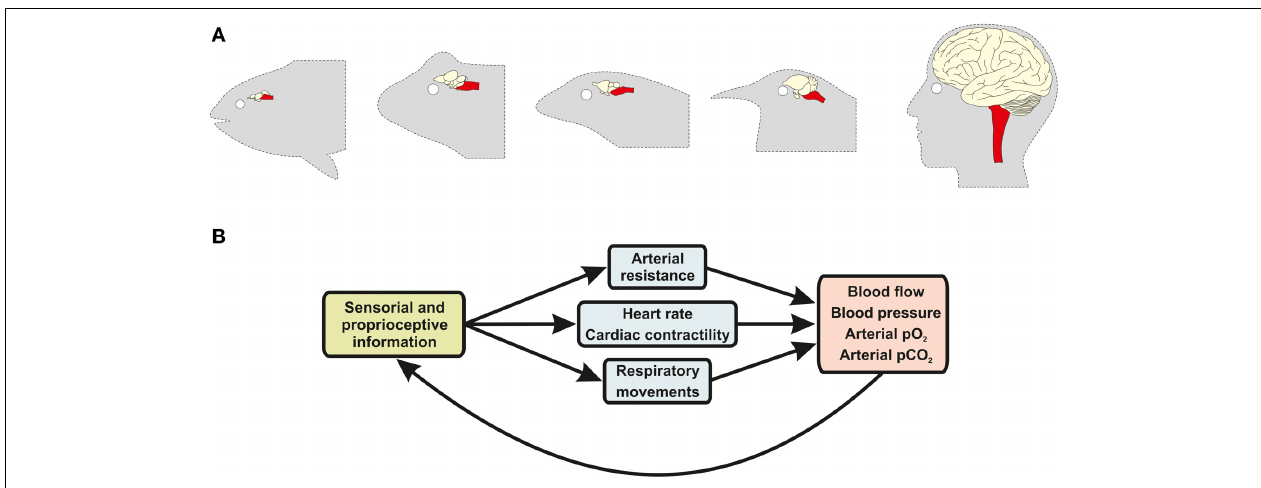
FIGURE 2 | Sensory-effector loops between the brain and the cardiovascular and respiratory systems regulate gas exchanges and blood flow. (A) Schematic illustrations of the brain of animals from five major vertebrate taxa, including bony fish, amphibians, reptiles, birds, and mammals (ordered from left to right). Brainstem anatomy and structure (red highlight) has remained conserved across vertebrate evolution, despite major changes in other brain regions (non-highlighted), due to the fact that this brain